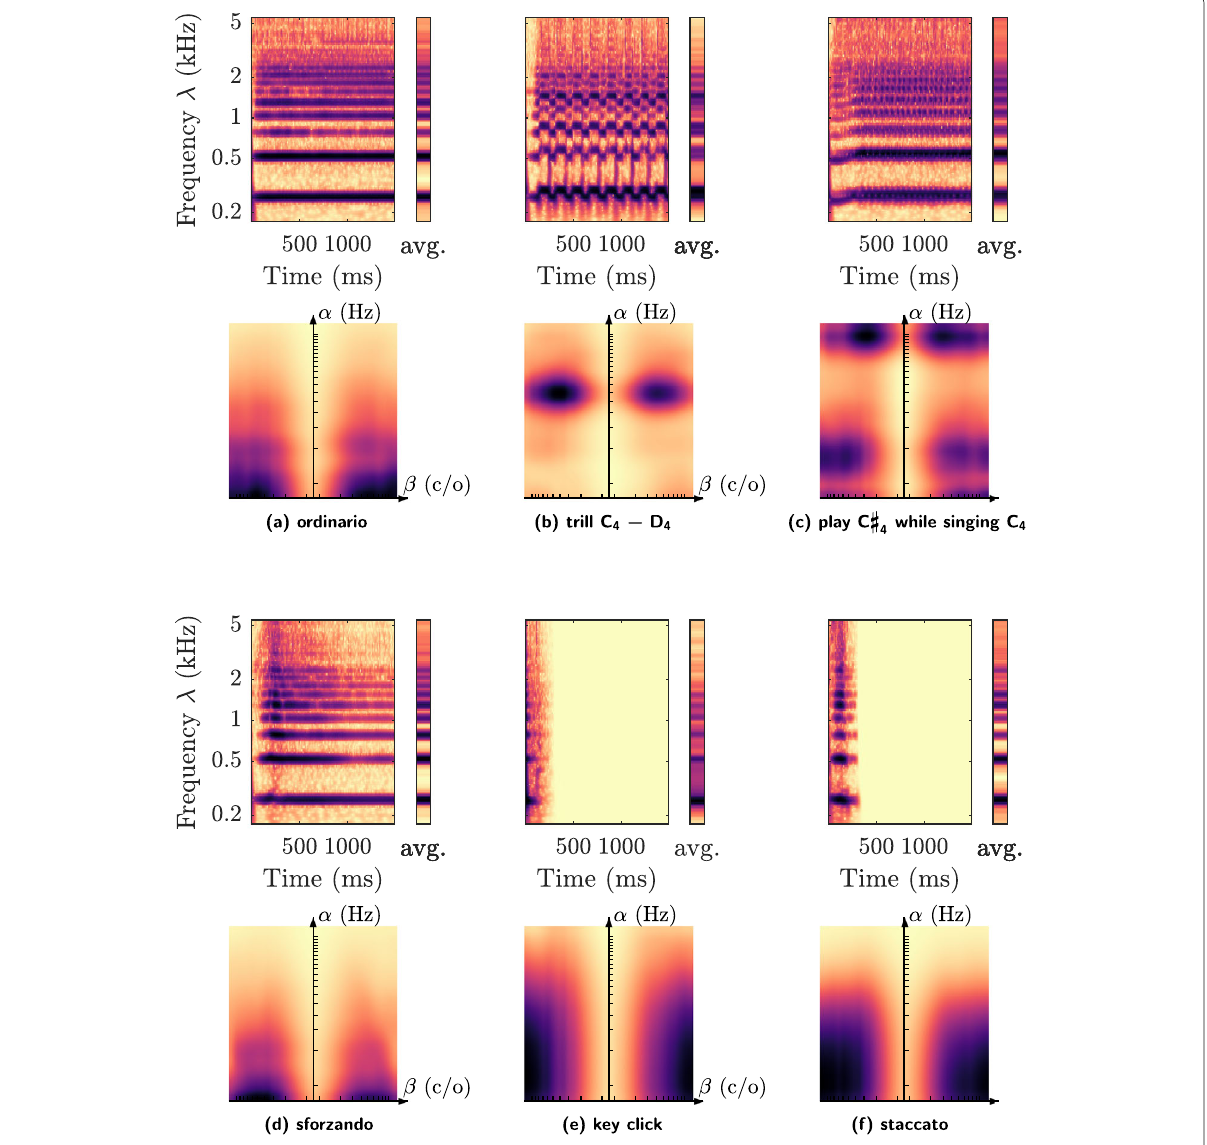
Fig. 4 Six playing techniques of the flute. Subfigures: a ordinario, b trill (C 4 − D 4 ), c interference (play C (cid:14) 4 while singing C 4 ), d sforzando, e key click, and f staccato. In each subfigure, the top image shows the wavelet scalogram as a function of time t (in seconds) and frequency λ (in Hertz). Conversely, the bottom image shows the average time–frequency scattering coefficients, as a function of temporal modulation rate α (in Hertz) and frequential modulation scale β (in cycles per octave). Darker shades denote greater values of acoustic energy. See Section 4 for